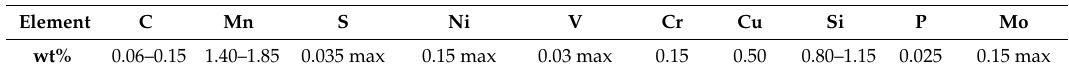
Table 2. Chemical composition of welding